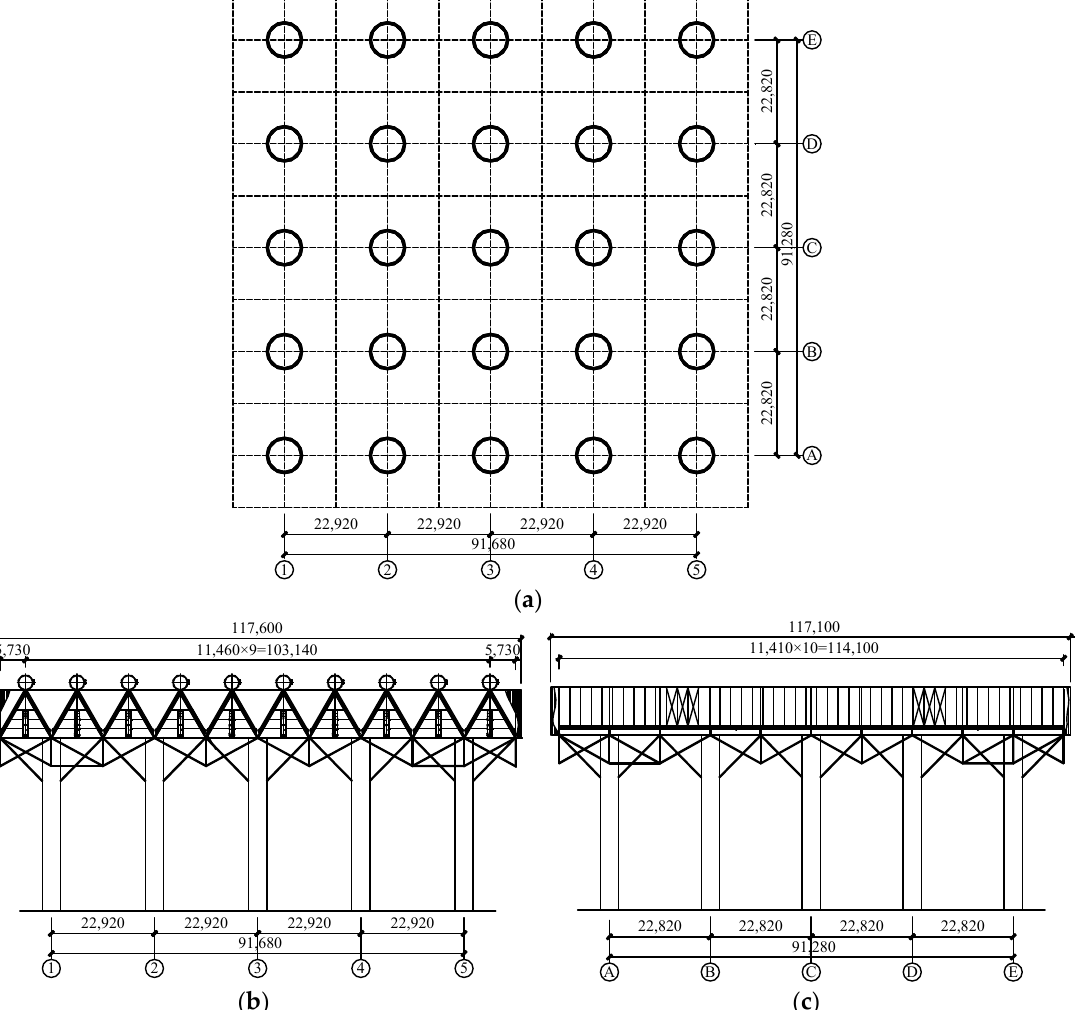
Figure 2. Structural layouts (unit: mm): ( a ) Plan layouts of RC tubular columns; ( b ) elevation view along the A-shaped frame direction; ( c ) elevation view perpendicular to A-shaped frame direction.